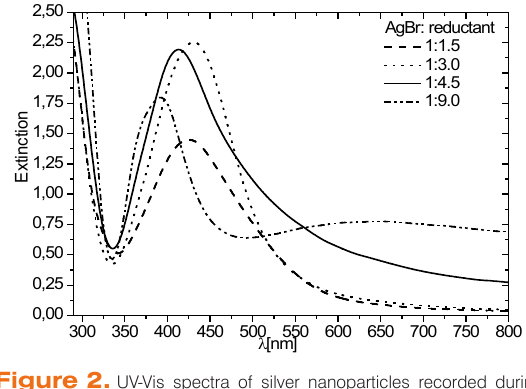
Figure 2. UV-Vis spectra of silver nanoparticles recorded during the photoreduction of AgBr crystals in the presence of ascorbic acid. The individual curves represent the various molar ratios of AgBr to ascorbic acid: 1:1.5, 1:3.0, 1:4.5 and 1:9.0.